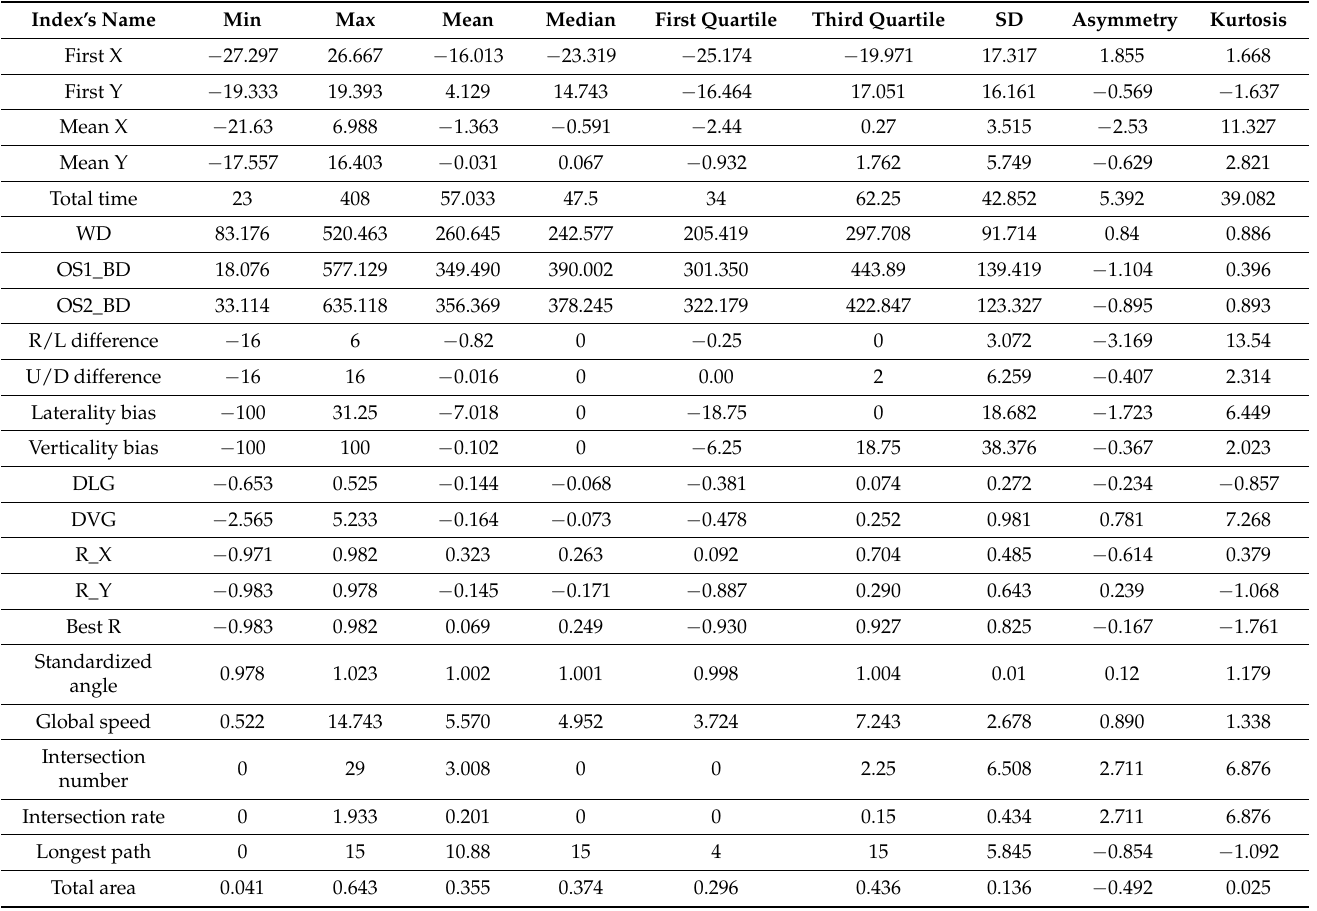
Table 2. Descriptive statistics for the list of indexes. OS1_BD = optima sequence number